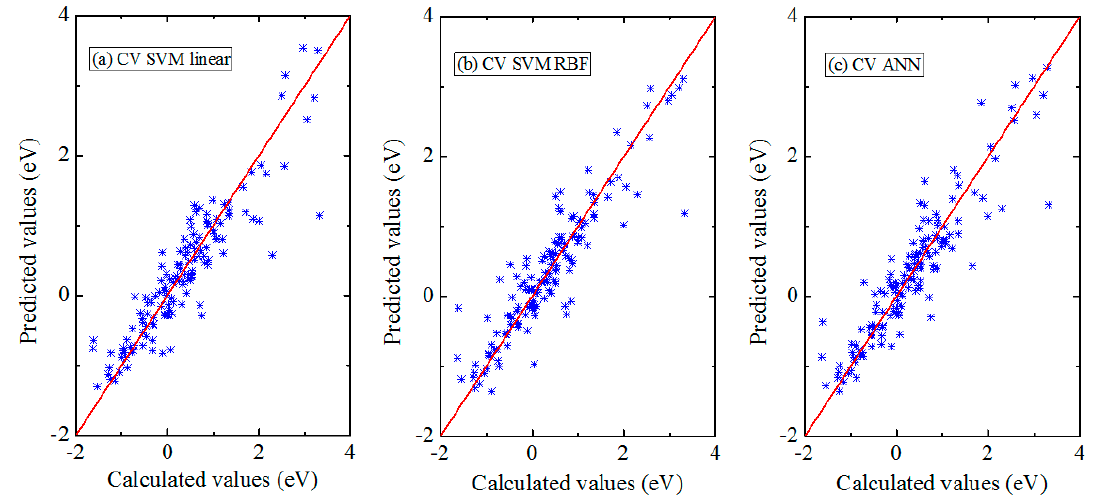
Figure 3. Comparison of ∆ E SE from the DFT calculations and the 10-fold cross validation prediction results using ( a ) SVM model with linear kernel, ( b ) SVM model with RBF kernel, and ( c ) ANN. Table 2. The values of parameter C for SVM model with linear kernel and parameters C and γ for SVM model with an RBF kernel. SVM with Linear Kernel SVM with RBF Kernel Group C C γ G1